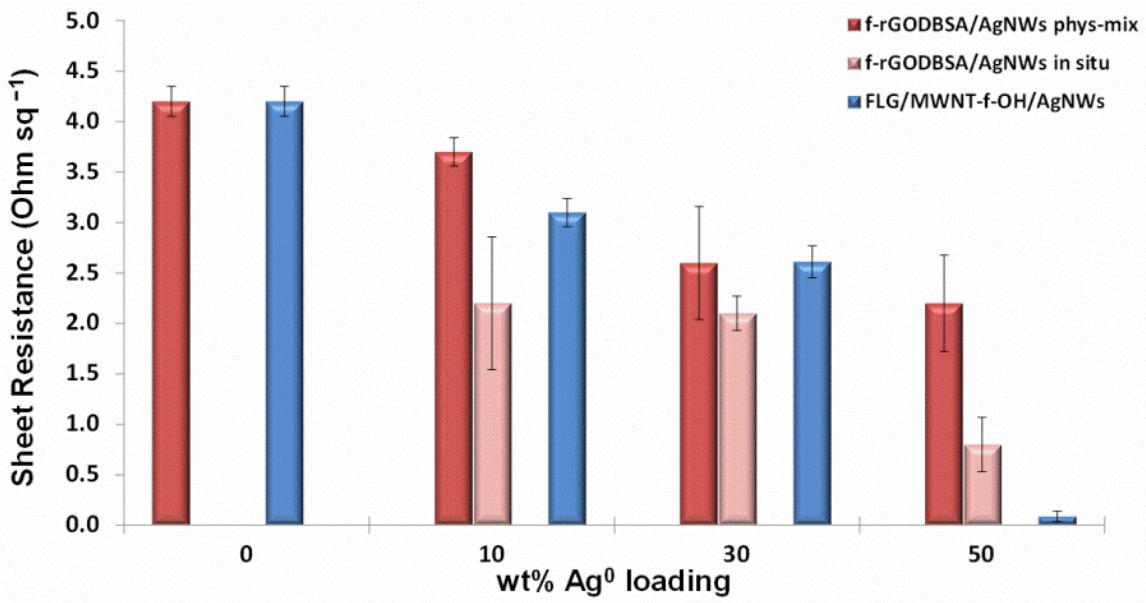
Figure 7. Sheet resistance of f -rGO DBSA , FLG/MWNT- f -OH, f -rGO DBSA /AgNWs, and FLG/MWNT- f -OH/AgNWs hybrid systems with three different metal loadings (10, 30, and 50 wt